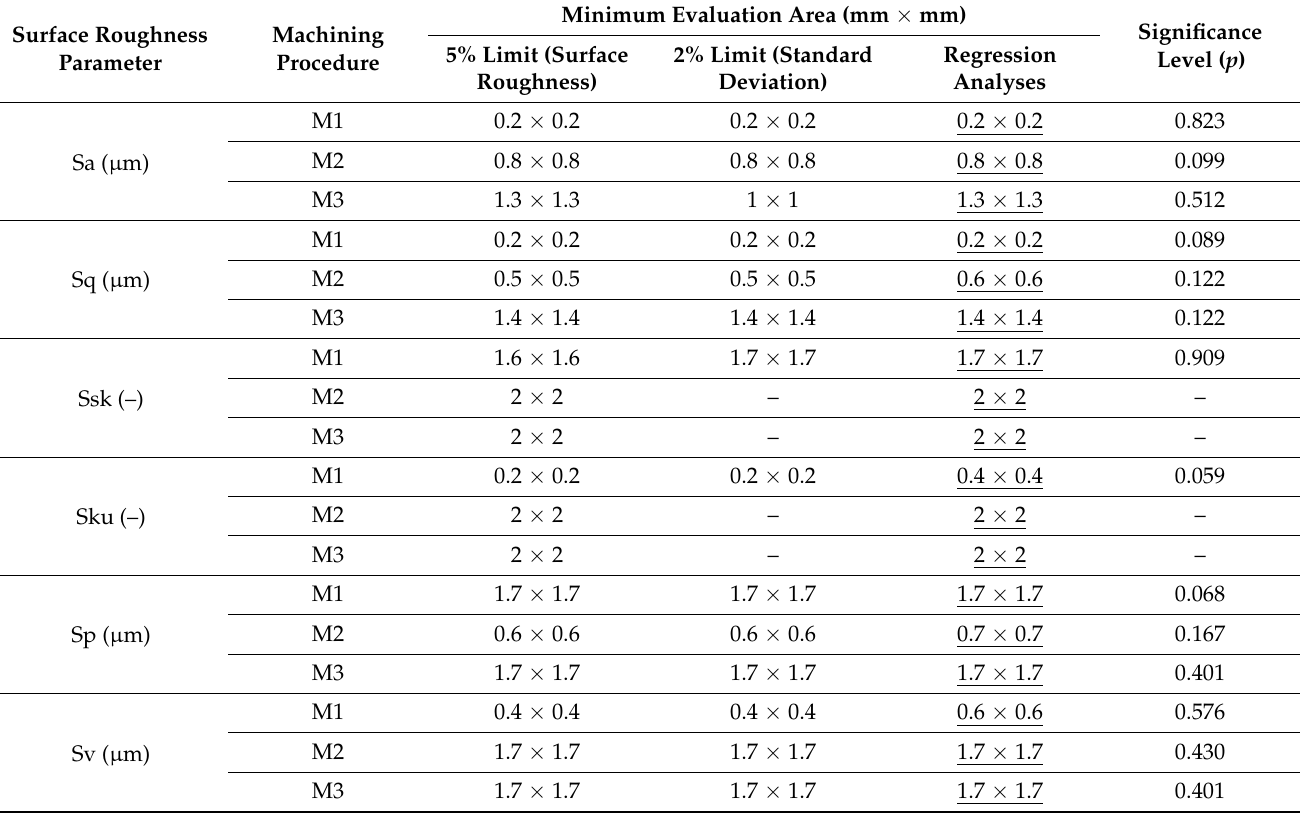
Table 5. Results of the minimization and the significance